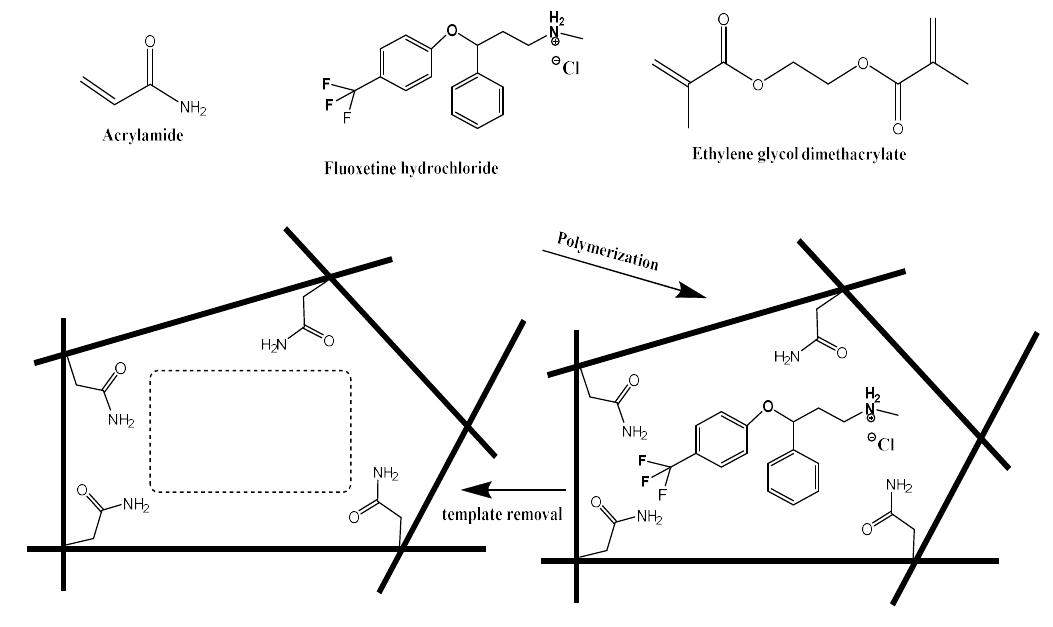
Figure 1. Schematic representation of noncovalent imprinting.